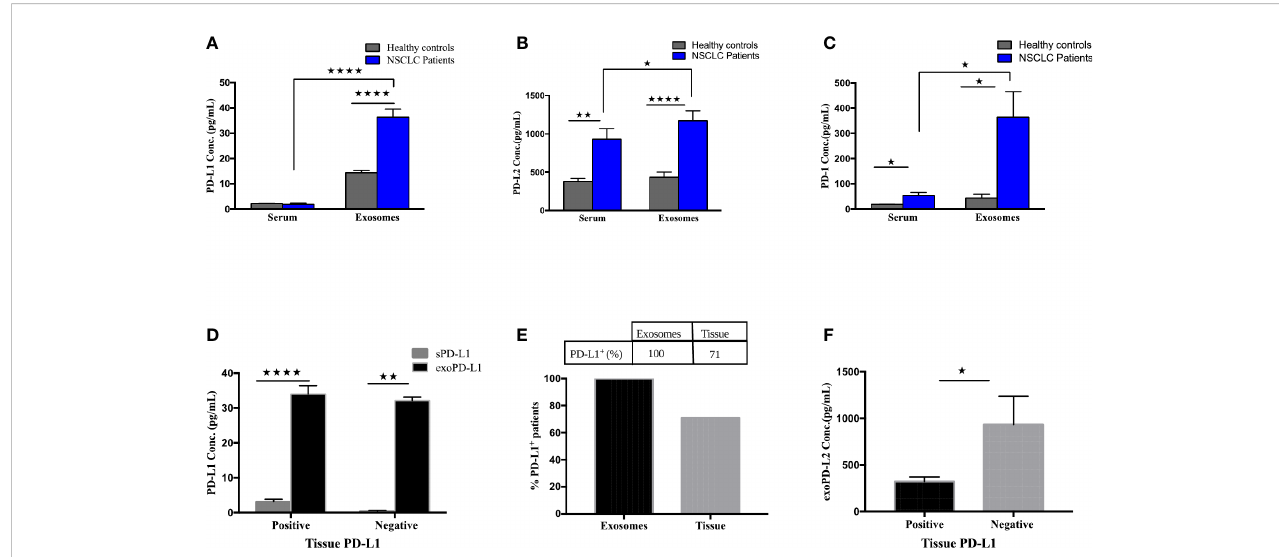
FIGURE 2 Expression of PD-L1, PD-L2 and PD-1 in circulating exosomes compared to free soluble forms or tumor biopsies. (A) PD-L1 levels in serum-derived exosomes of NSCLC patients compared with free soluble forms in the serum (p<0.0001). (B) PD-L2 levels in serum-derived exosomes of NSCLC patients compared with free soluble PD-L2 in the serum (p=0.0413). (C) PD-1 levels in serum-derived exosomes of NSCLC patients compared with free soluble PD-1 in the serum (p=0.0131). (D) Expression of exoPD-L1 and serum PD-L1 between tissue-PD-L1 positive and tissue-PD-L1 negative NSCLC patients (for positive grp, p<0.0001; for negative patients, p=0.0079). (E) Percentage of PD-L1 positive patients compared between circulating exosomes and tumor samples. (F) exoPD-L2 expression between tissue-PD-L1 positive and negative patients (p=0.0193). * signi fi cant; ** moderate signi fi cant; **** Highly signi fi